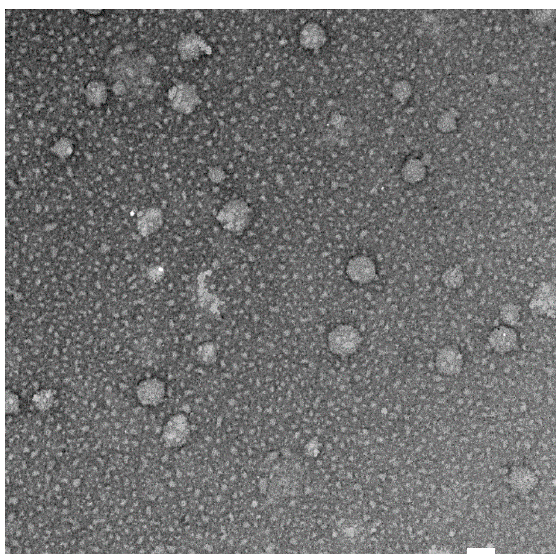
Figure 2. TEM image of quercetin loaded niosomes (F2) at magnification of ×30,000, white bar 100 nm.